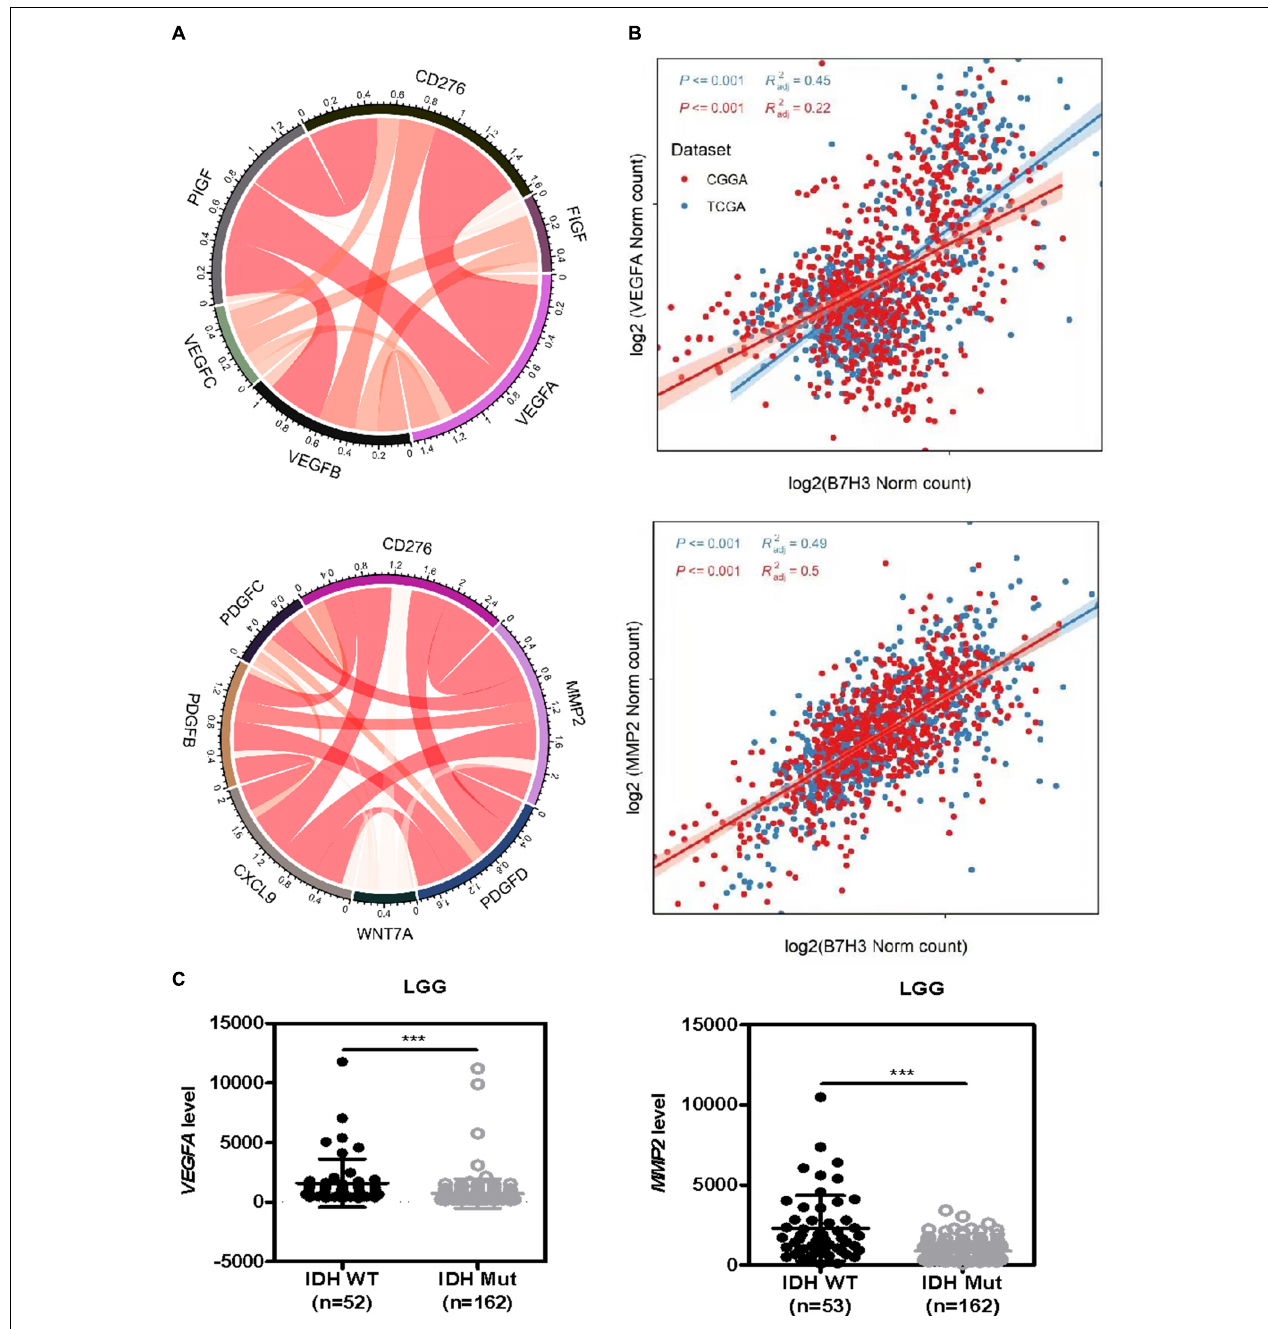
FIGURE 4 | B7H3 is positively correlated with VEGFA and MMP2 in gliomas. (A) Circos analysis was performed to analyze the interactions among B7H3 and 11 key angiogenesis-related cytokines. (B) The relationship of B7H3 and VEGFA or MMP2 was analyzed according to the TCGA and CGGA databases. (C) Angiogenesis-related VEGFA and MMP2 mRNA levels are decreased in IDH-mutated LGG according to the TCGA dataset. For VEGFA analysis, n = 52 in IDH-WT and n = 162 in IDH-MUT LGG, respectively, for MMP2 analysis, n = 53 in IDH-WT and n = 162 in IDH-MUT LGG, respectively. ***denotes the P < 0.001 for the indicated